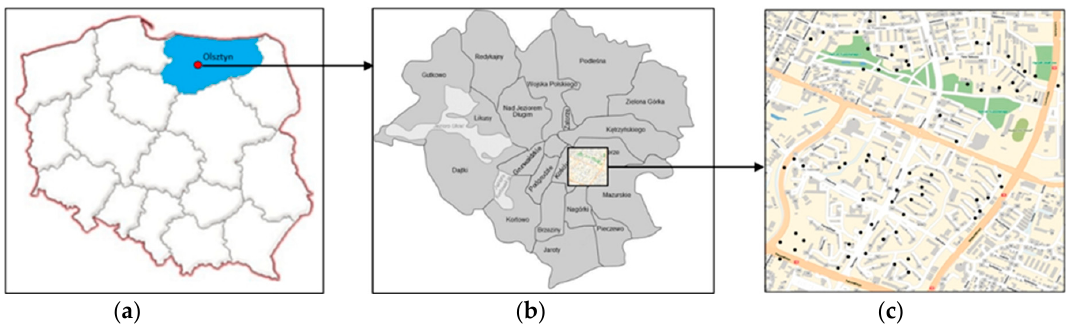
Figure 1. Distribution of measurement points in the analyzed area; ( a ) location of the city of Olsztyn on a map of Poland (own elaboration based on http://nastadiony.pl/); ( b ) map of residential estates in Olsztyn (own elaboration based on http: // olsztyn.wm.pl / ); ( c ): location of the analysed objects in 2012 (own elaboration based on http://www.zumi.pl/).